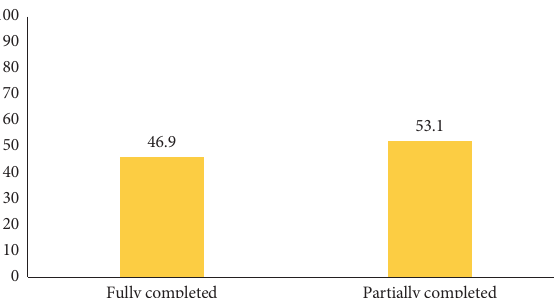
Figure 2: Completion of CWC at the current age ( n � 213).